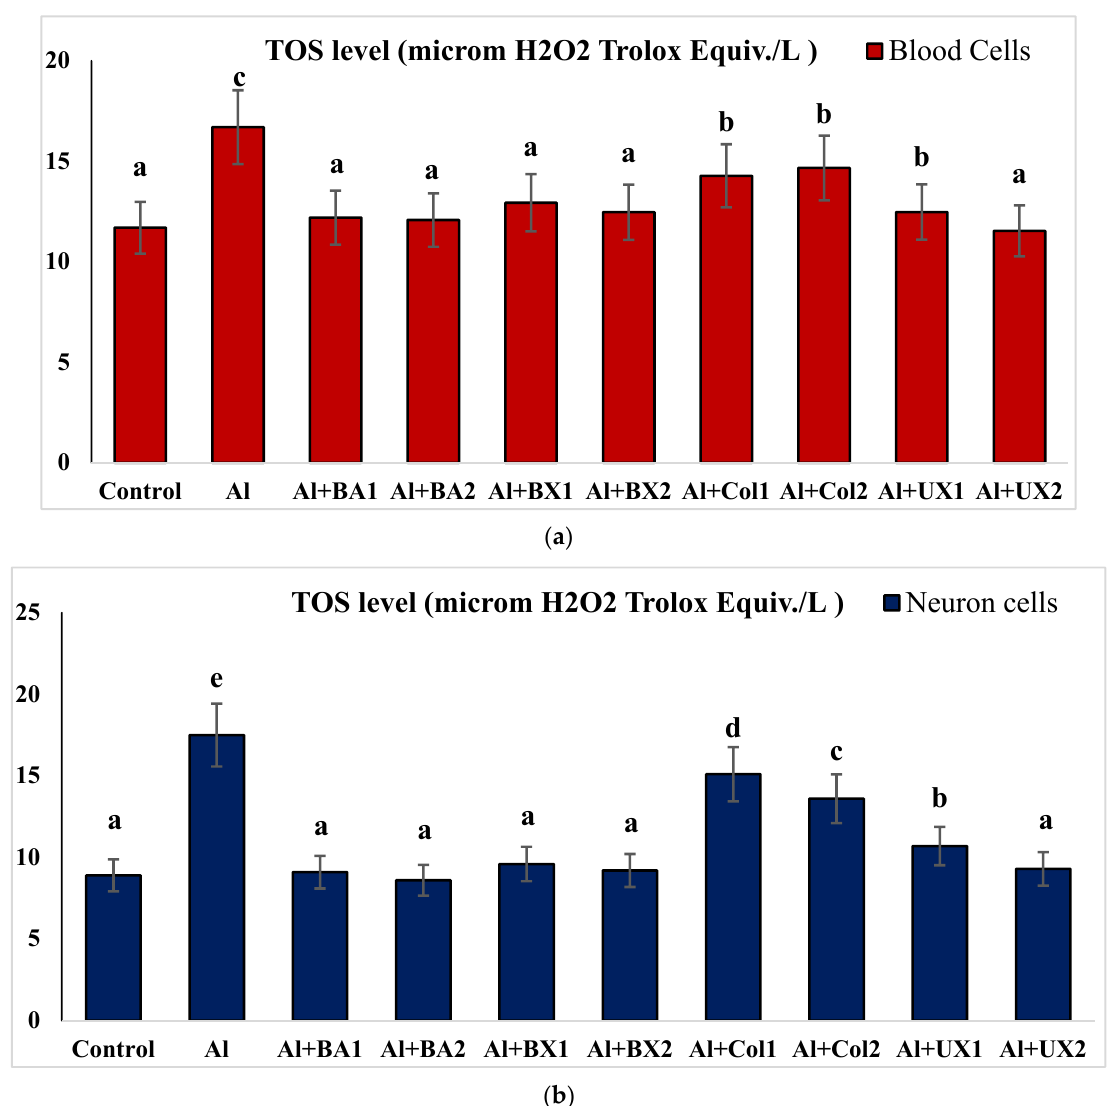
Figure 5. The effect of Al and boron treatments in ( a ) human blood and ( b ) PRCNs on TAC levels. Abbreviations are as in Figure 2. (Each superscript letter (a, b, c, d, e) represents statistically similar groups).